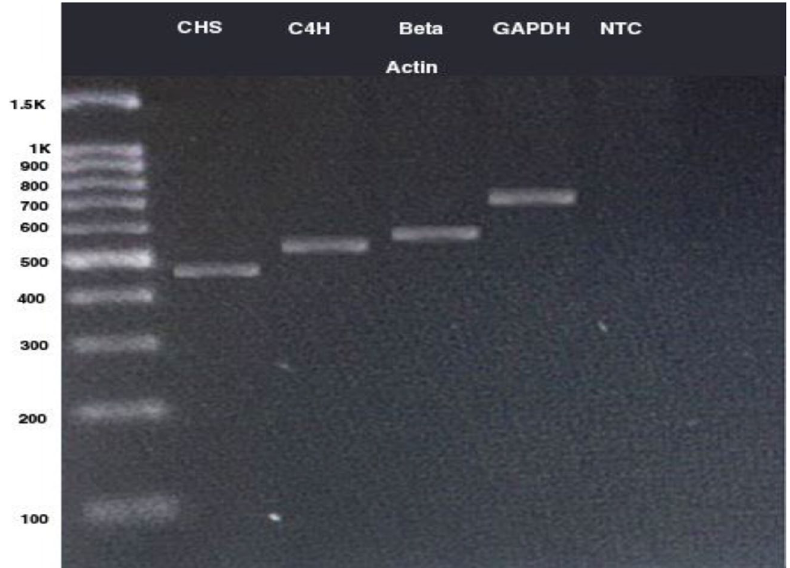
Figure 10. PCR analyses for CHS, C4H. Beta Actin and GAPDH